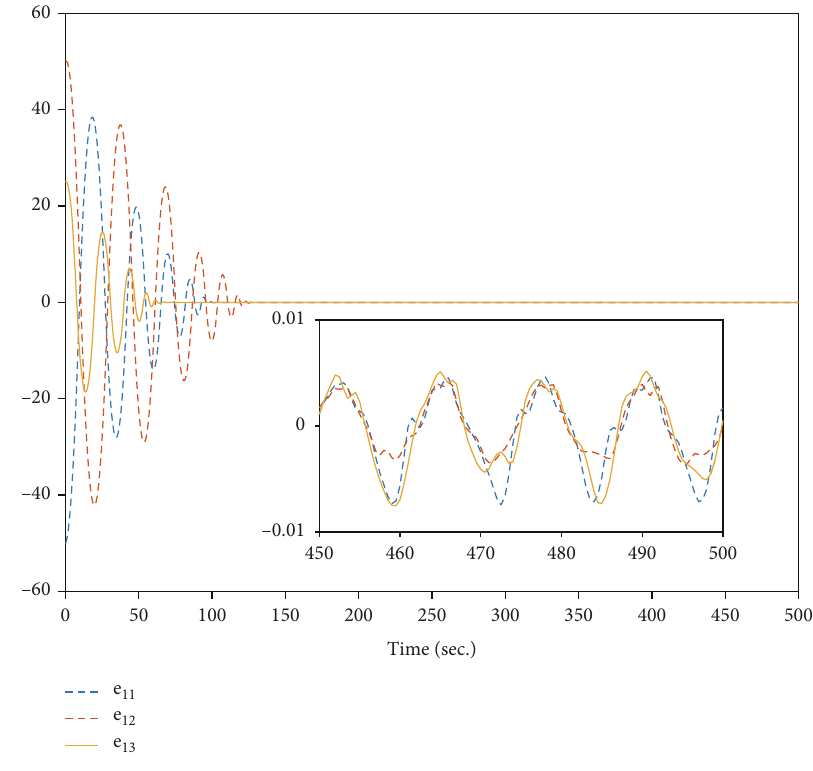
Figure 3: Response curves of position tracking